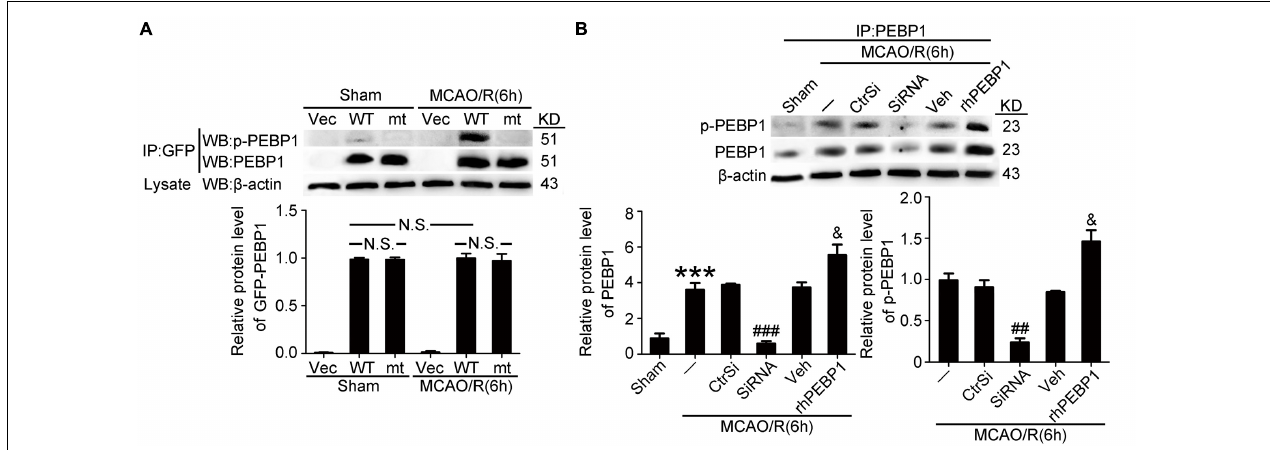
FIGURE 4 | Transfection efficiency of PEBP1 expression vectors and siRNAs and the effect of rhPEBP1 on PEBP1 phosphorylation in penumbra tissue at 6 h after MCAO/R conditions. (A) Immunoprecipitation (IP) of tissue lysates with GFP antibody to enrich GFP-PEBP1 from total proteins. Western blots of IP with indicated antibodies showed the transfection efficiency of PEBP1 expression vectors and the phosphorylation of wide type GFP-PEBP1 and GFP-PEBP1 (S153A). There were no significant changes between the protein level of wide type GFP-PEBP1 and GFP-PEBP1 (S153A) both in sham group ( p = 0.381) and MCAO group ( p = 0.408) ( n = 6/group). (B) IP of tissue lysates with PEBP1 antibody to enrich PEBP1 from total proteins. Western blot analysis and quantification of the level of PEBP1 and p-PEBP1. Phosphorylation levels were evaluated by the ratio of p-PEBP1 to β -actin. In PEBP1, ∗∗∗ p < 0.001 vs. sham group, ### p < 0.001 vs. MCAO/R + control-siRNA group, & p = 0.035 vs. MCAO/R + vehicle group. In p-PEBP1, ## p = 0.0031 vs. MCAO/R + control-siRNA group, & p = 0.029 vs. MCAO/R + vehicle group ( n = 6). Statistical comparisons between groups were performed using one-way analysis of variance followed by either a Dunnett’s or